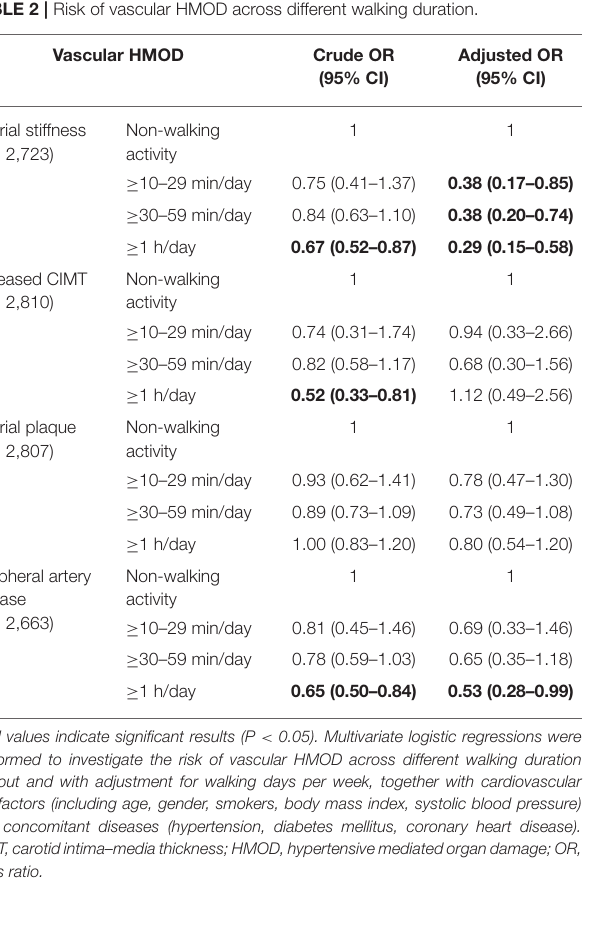
TABLE 2 | Risk of vascular HMOD across different walking duration.